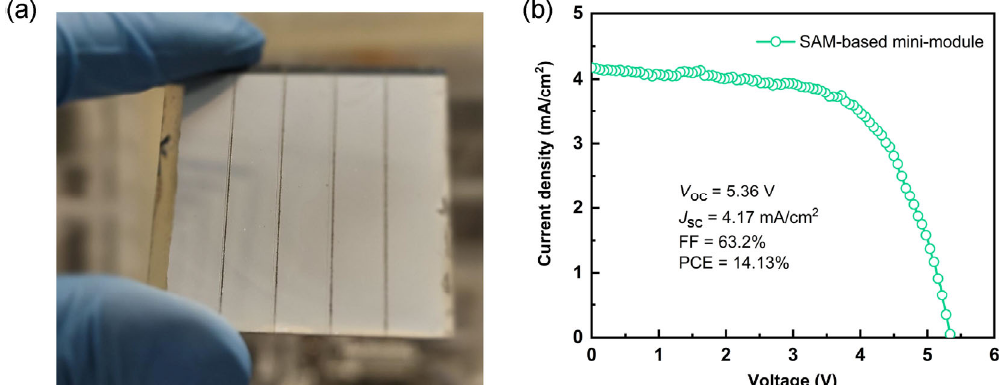
Figure 6 (a) Photography of SAM-based perovskite mini-module (5 cm × 5 cm) by blade-coating method. (b) J–V characteristics of SAM-based perovskite mini-module fabricated by blade-coating with an aperture area of 18.0 cm 2